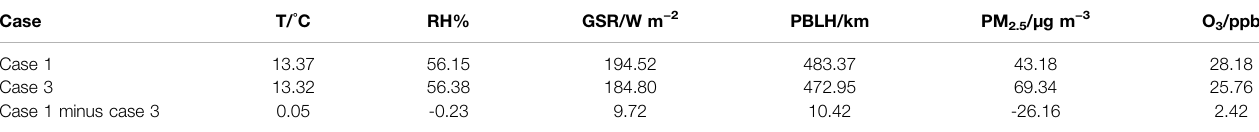
TABLE 6 | Effects of emission reduction on meteorological elements and pollutants.